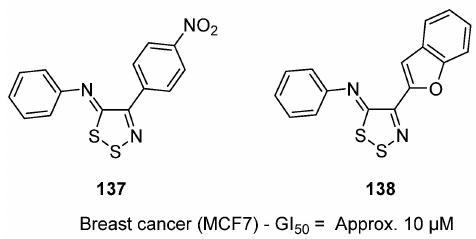
Figure 30. Substituted C4 1,2,3-dithiazoles with activity against breast